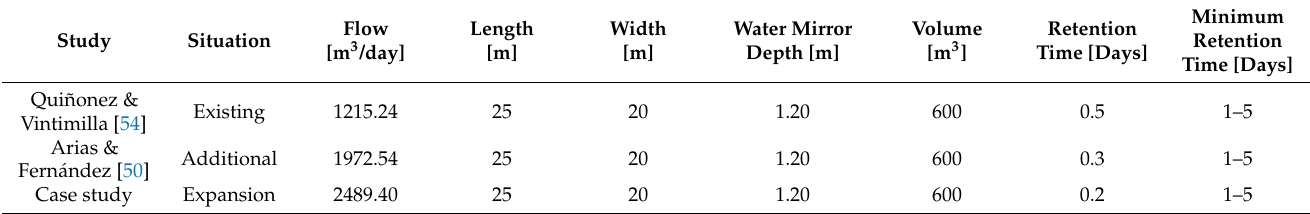
Table 18. Hydraulic retention times of the stabilisation pond located in CA2.